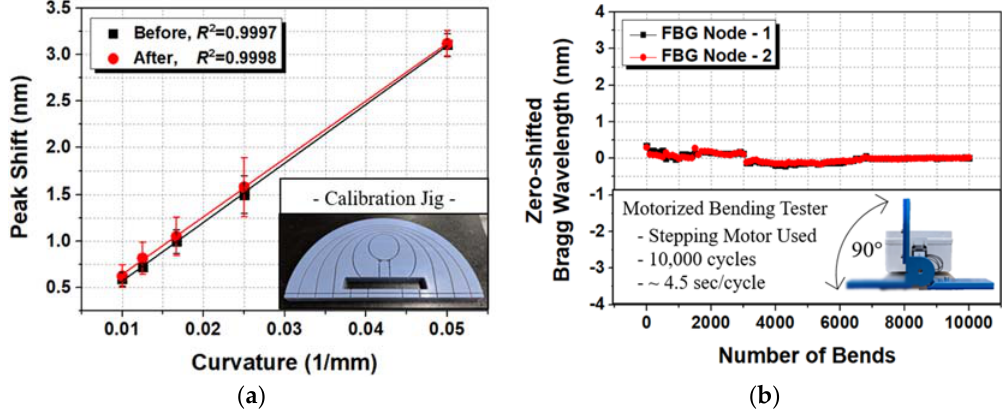
Figure 3. Evaluation of the FBG strain sensor: ( a ) Peak shift change by curvature and ( b ) zero ‐ shifted Bragg wavelength during the high ‐ cycle durability test.